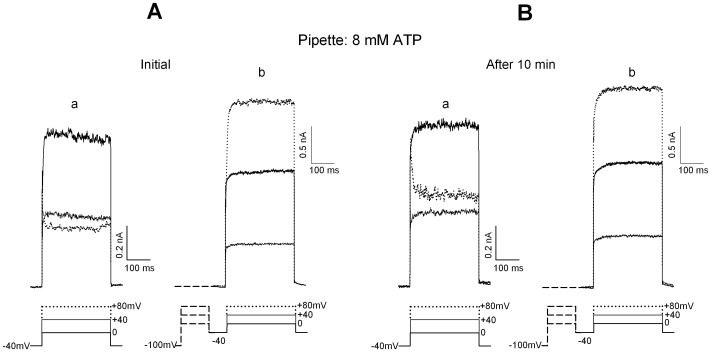
The restoring effect of ATP on delayed potassium currents.
A and B. The evoked currents are recorded with 8 mM ATP in the pipette, under the same conditions as in Fig. 1. The tracings corresponding to the conditioning period at −100 mV and the subsequent IA+IKD responses are not shown in Ab and Bb, for clarity. Note that both IKD peak amplitude and the efficiency of inactivation removal are preserved over the whole observation period.